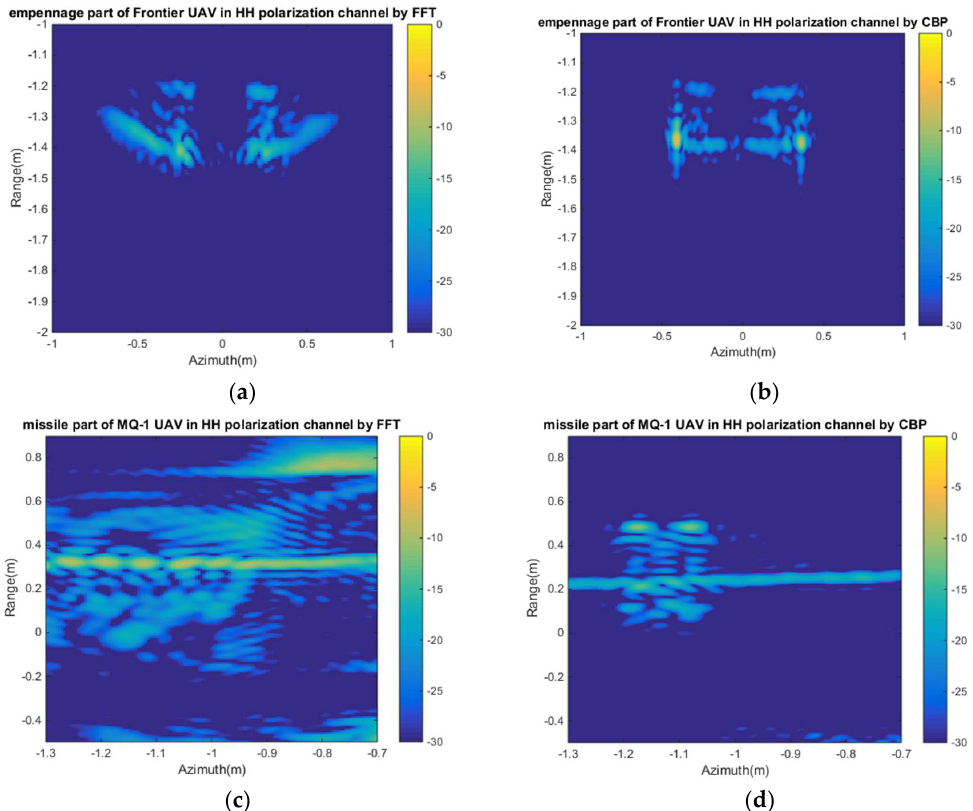
Figure 7. The empennage and missile parts of “MQ-1” UAV with FFT and CBP algorithm. ( a ) Empennage part of “MQ-1” in HH polarization by FFT; ( b ) Empennage part of “MQ-1” in HH polarization by CBP; ( c ) Missile parts of “MQ-1” in HH polarization by FFT; ( d ) Missile parts of “MQ-1” in HH polarization by CBP.